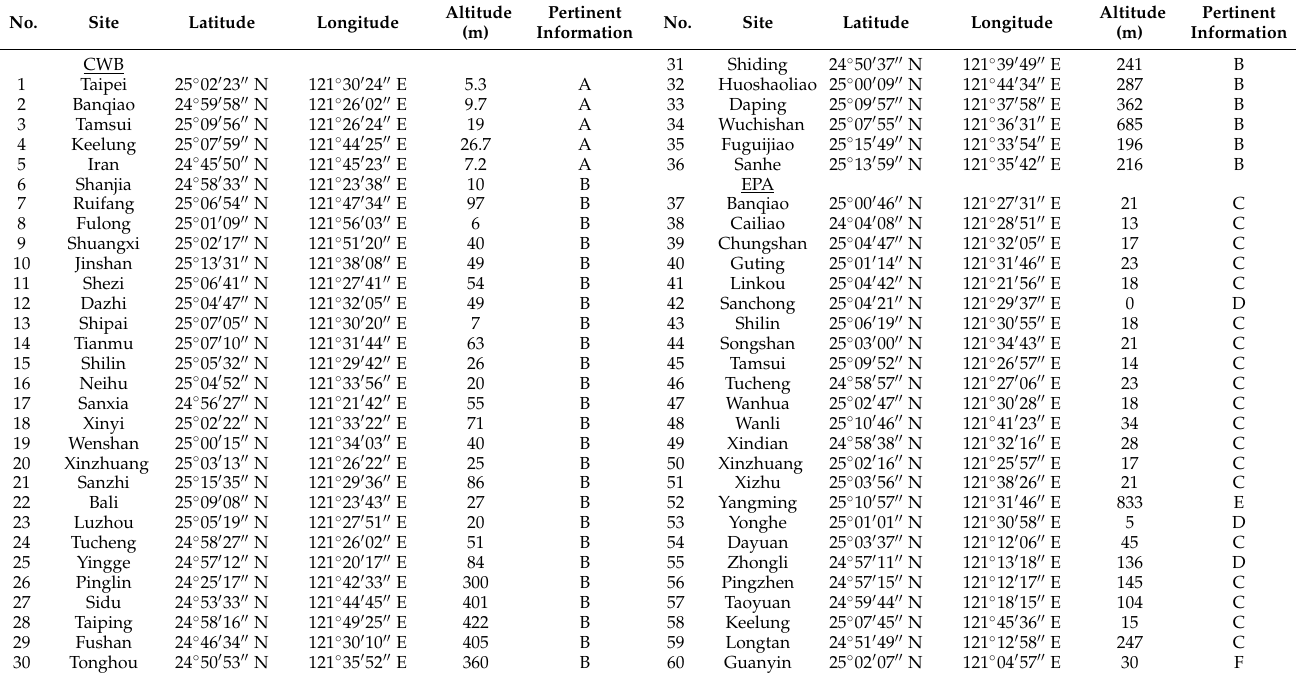
Table 1. Geographical information of the 36 meteorological sites and 24 air quality monitoring